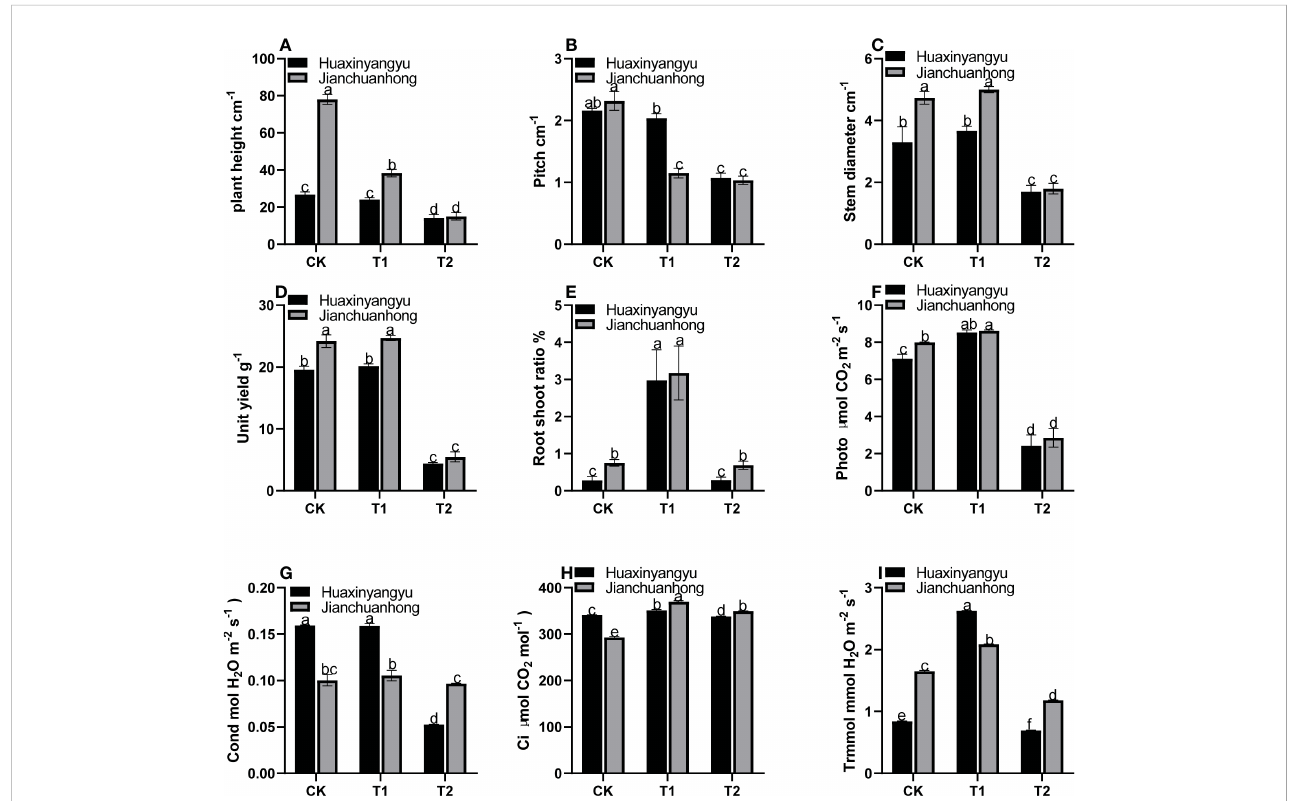
FIGURE 1 Effects of different UV-B treatments on agronomic characters and harvest indexes of “ Huaxinyangyu ” and “ Jianchuanhong ” . (A) Plant height, (B) pitch, (C) stem diameter, (D) unit yield, (E) root shoot ratio, (F) photosynthetic rate (Photo), (G) stomatal conductance (Cond), (H) respiration rate (Ci), (I) transpiration rate (Trmmol) (According to the Duncan test, different letters indicate a signi fi cant difference (p< 0.05) among the treatments, The error bars represent the mean ± SE. The X-axis represents processing, and the Y-axis represents height, percentage, and